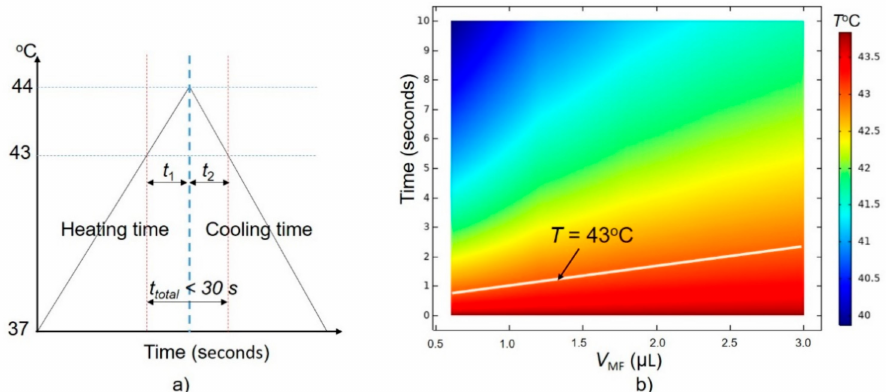
Figure 6. ( a ) A feasible condition for wireless magnetothermal simulation (WMS), ( b ) dependence of cooling time on V MF with the initial temperature of the stimulation treatment equal to 44 ◦